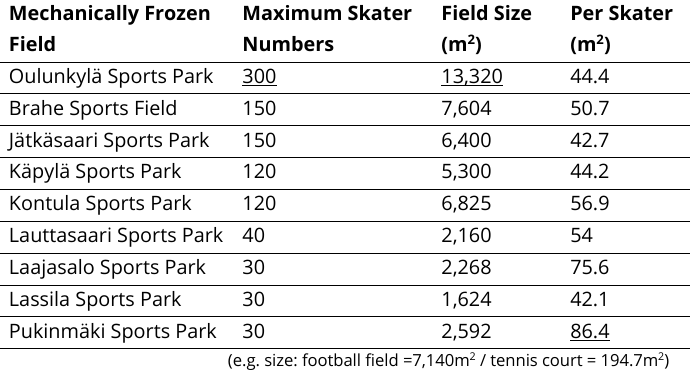
Table 2. Maximum number of skaters at each mechanically frozen ice skating